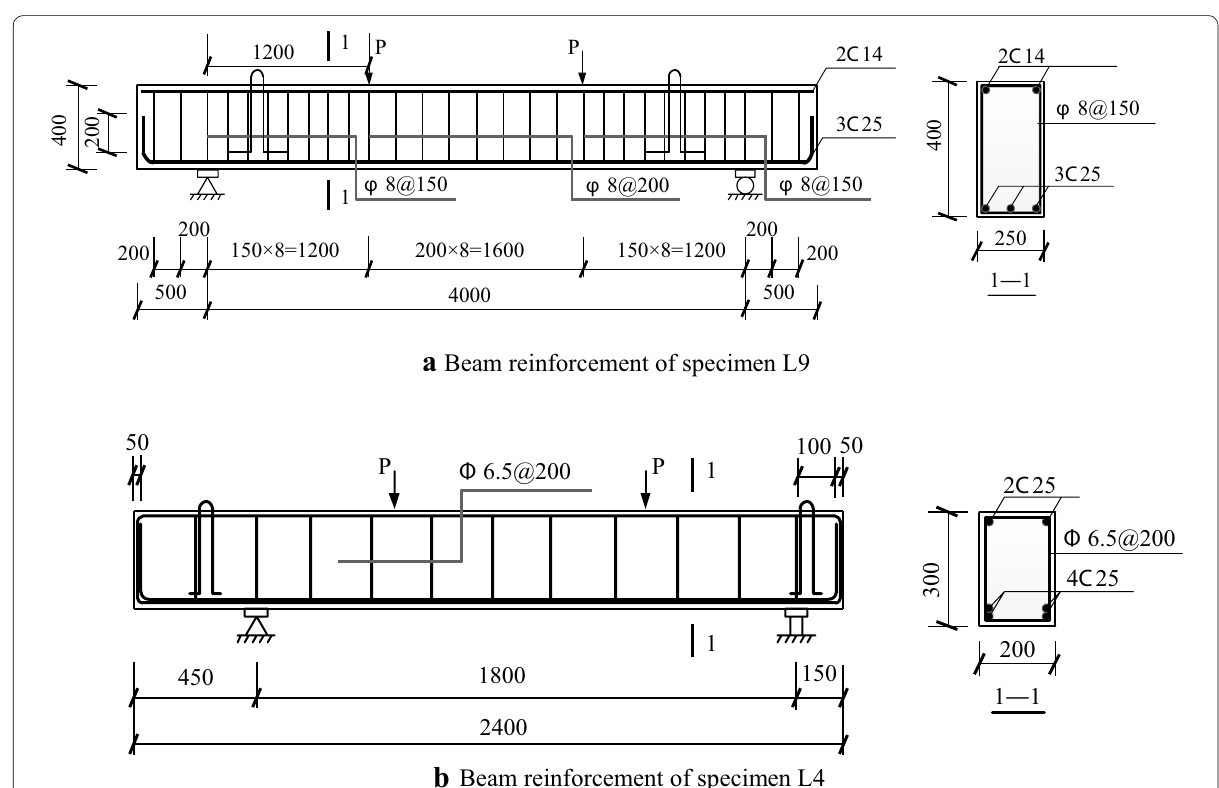
Fig. 4 Beam reinforcement of